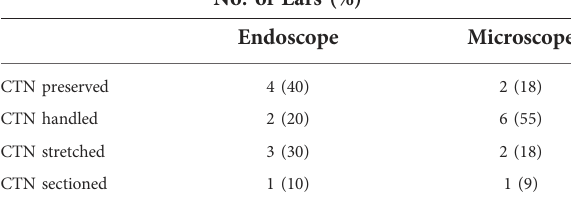
TABLE 1 Chorda tympani (CT) trauma by surgical technique. There was no statistically signi fi cant difference in CT trauma between the endoscopic and the microscopic